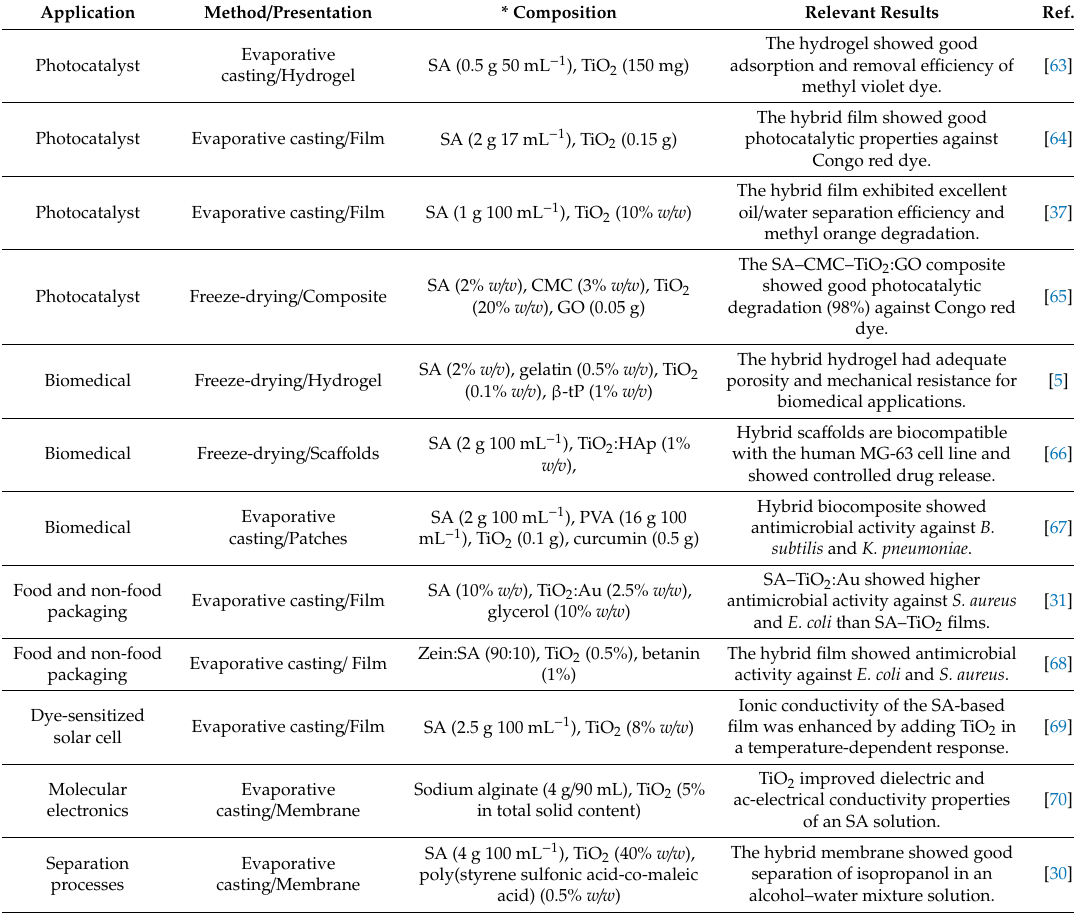
Table 2. E ff ect of TiO 2 incorporation on sodium alginate matrix